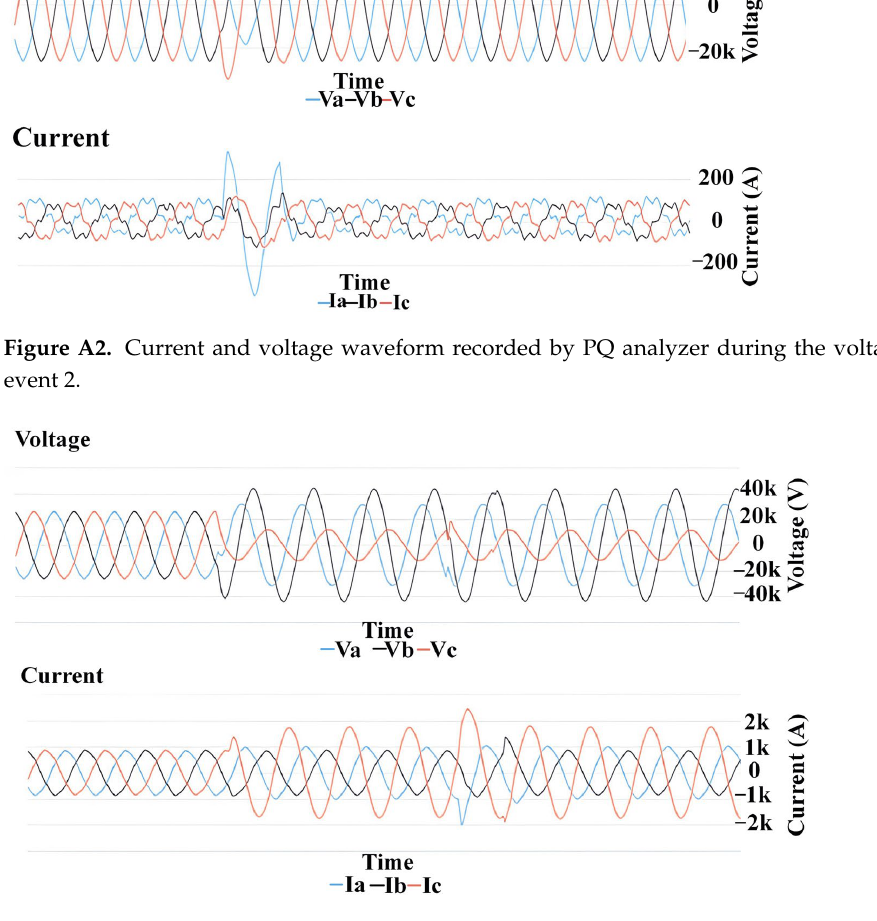
Figure A3. Current and voltage waveform recorded by PQ analyzer during the voltage sag for event 3.